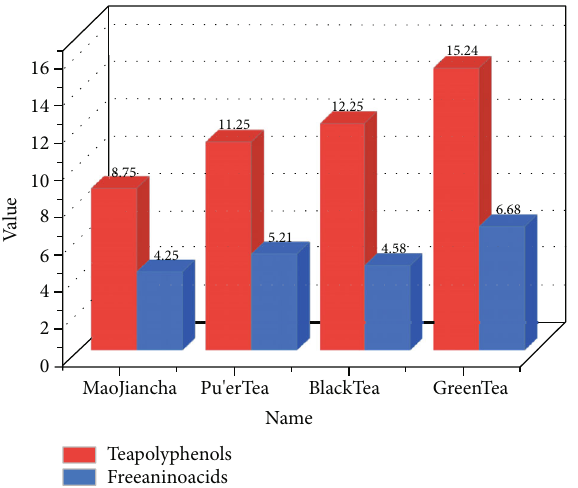
FreeaninoacidsMaoJiancha Teapolyphenols Figure 5: Comparison of free amino acid content and tea polyphenol content of the four